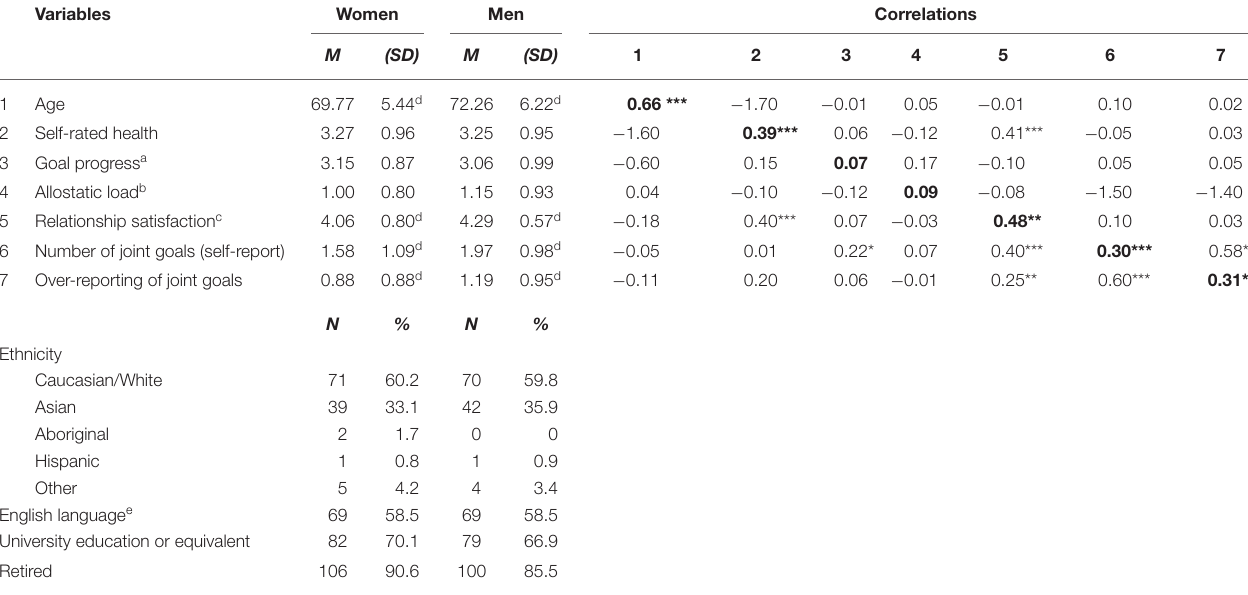
TABLE 1 | Descriptive statistics and correlations of sample characteristics ( N = 236) and study variables. Variables